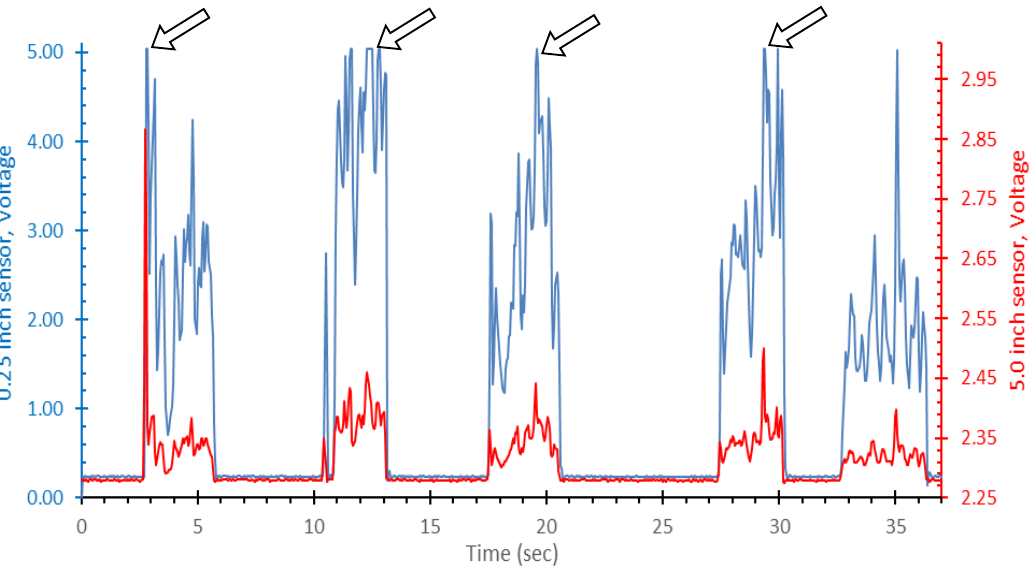
Figure 3. A representative sample plot of sensor voltage ( y -axis) versus time ( x -axis) for 0.71 L challenge puffs conducted at low flow. The left-hand scale (blue) corresponds to the 0.25-inch sensor signal. The right-hand scale (red) corresponds to the 5.0-inch sensor signal. The 0.25-inch sensor is displayed across its full measurement range while the 5.0-inch sensor is only displayed across the observed values. Arrows are pointing to instances of signal saturation from the 0.25-inch sensor.